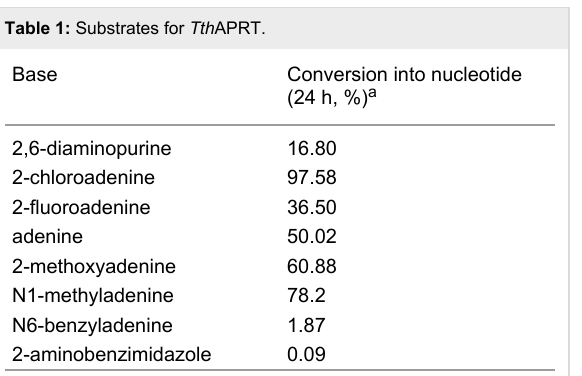
Figure 2: Nucleotide synthesis using